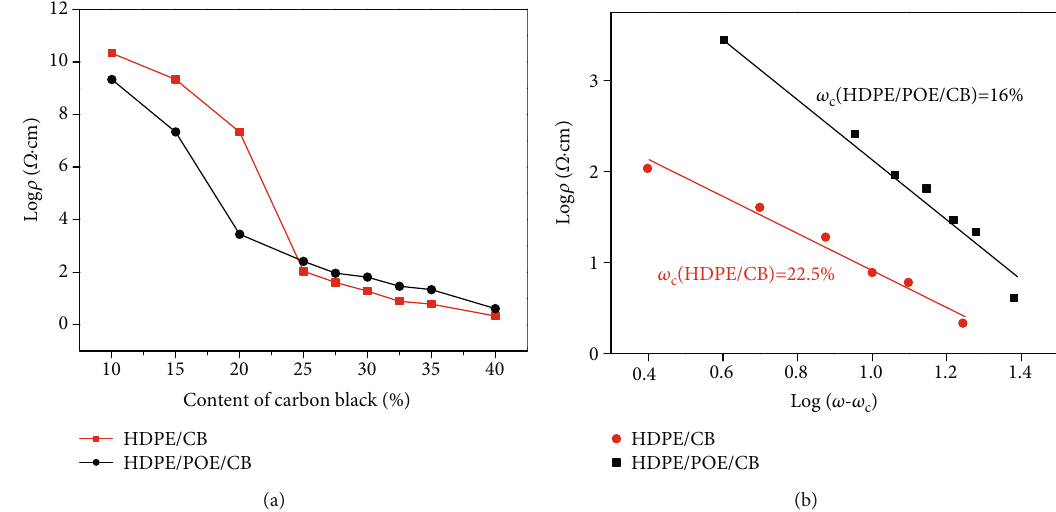
Figure 1: (a) Electrical conductivity as a function of the CB content; (b) fi tting of experimental results with percolation